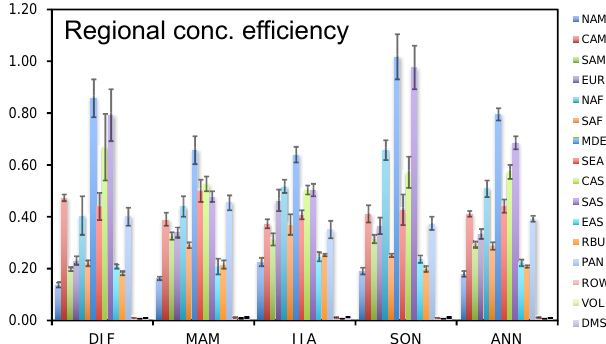
Figure 7. Seasonal and annual mean regional concentration effi- ciency of sulfate (µgm − 3 (Tg Syr − 1 ) − 1 ) of the 16 tagged source regions/sectors. The efficiency is defined as the local contribution to near-surface sulfate concentrations divided by the corresponding sulfur emissions from that region (seasonal emissions multiplied by 4). Error bars indicate 1 σ of mean values during years 2010– 2014. The receptor region of ROW is used to calculate efficiency of VOL and